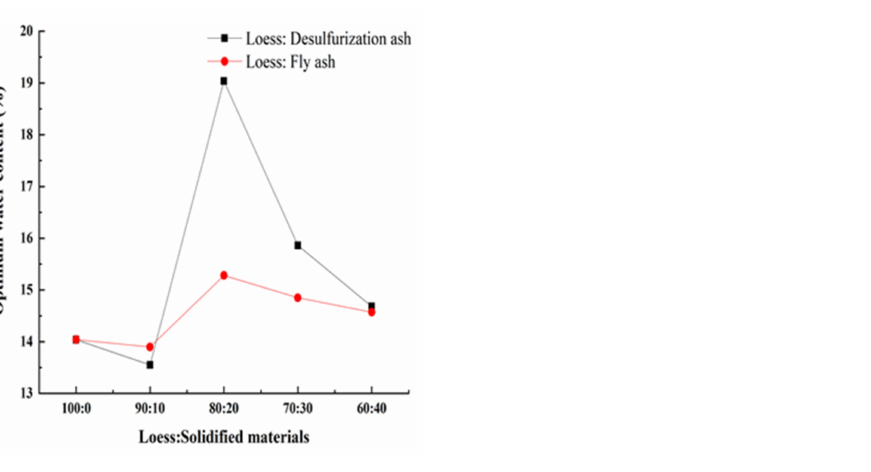
Figure 5. The relationship between optimal moisture content and solidified